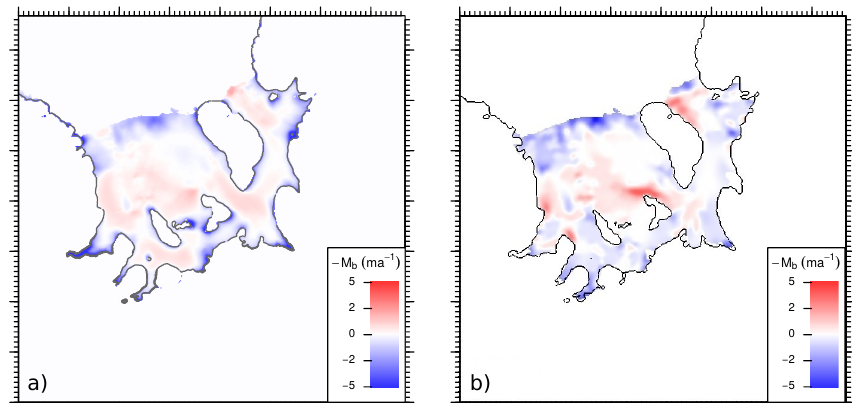
Figure 3. (a) Combined grounding line and ambient basal mass balance fields for floating ice at time t = 0years. (b) Basal mass balance of the Filchner–Ronne Ice Shelf calculated by Joughin and Padman (2003) from measured ice velocity, ice thickness and snow accumulation and assuming a steady